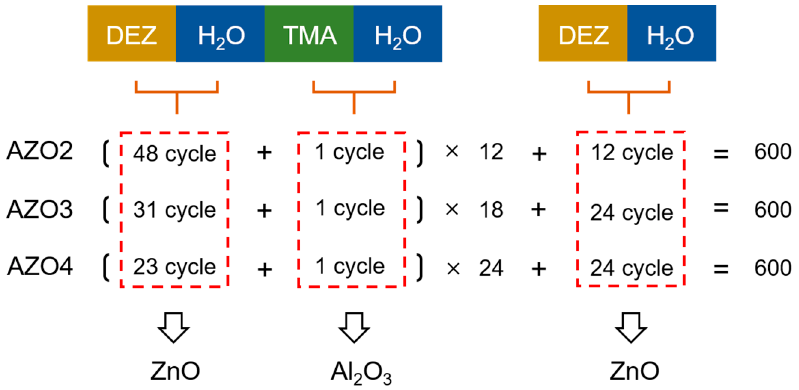
Figure 1. Schematic diagram of fabrication methods for AZO films. Total cycle number of AZO films are 600.